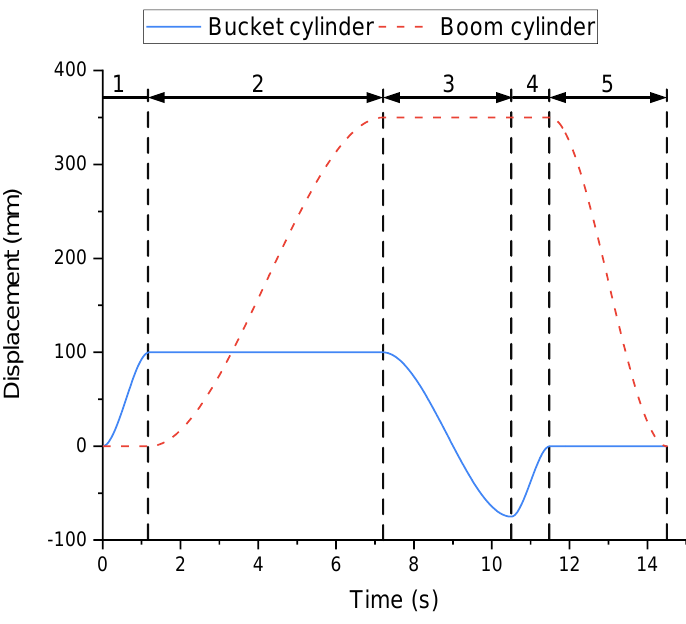
Figure 9. Hydraulic cylinder